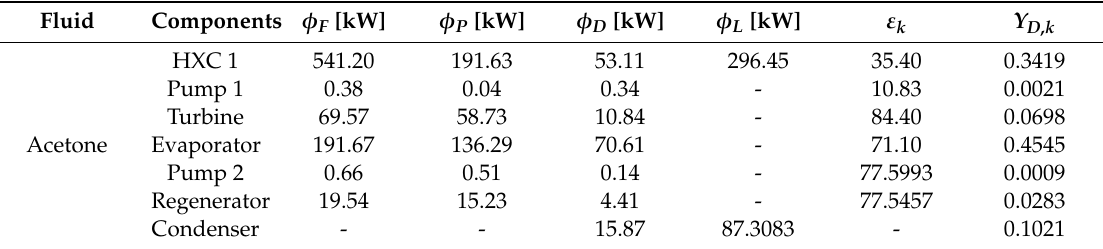
Table 6. Exergy analysis for each component of the WHRS system based on the RORC system using acetone.